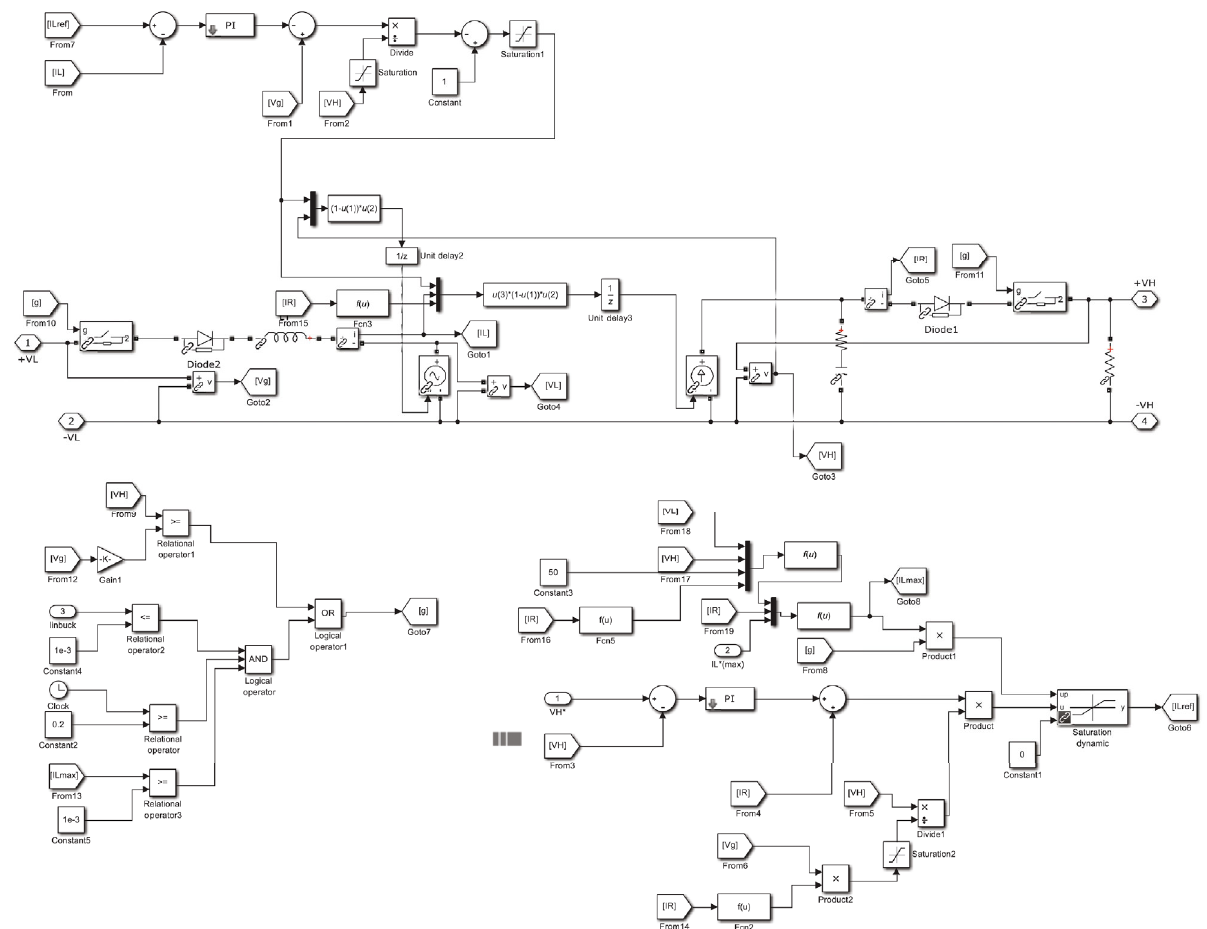
Figure 7: DC to DC boost converter model in Simulink/SimPowerSystems (SPS).